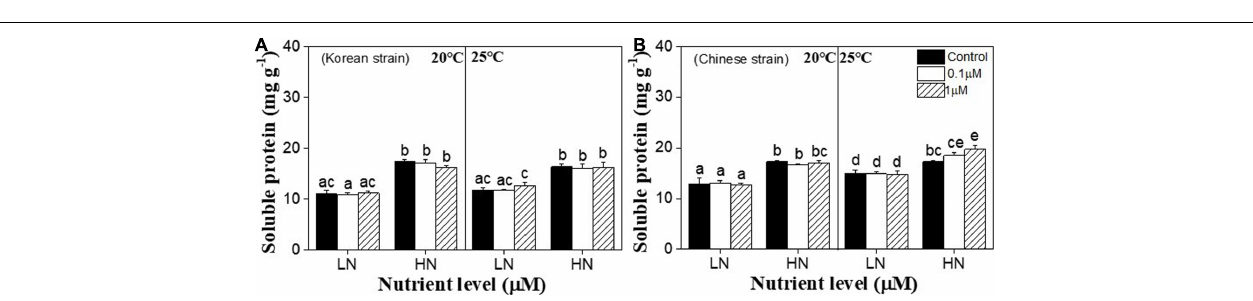
enhancing effect was observed in the interactions between 25 ◦ C and high nutrients ( P < 0.05) ( Figure 2D